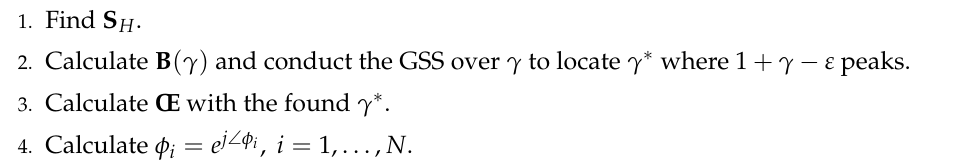
Algorithm 2 : AP pre-coder optimization